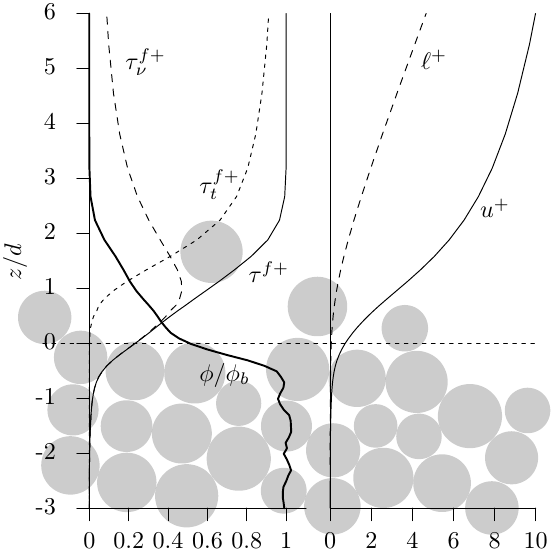
Fig. 1. Vertical profiles of the rescaled volume fraction φ/φ b , flow velocity u + = u/u ∗ , mixing length ‘ + = ‘/d , fluid borne + 2 shear stress τ f + = τ f /ρ f u 2 ∗ , viscous shear stress τ f ∗ ν = ν∂ z u/u + = (‘∂ z u) 2 /u 2 ∗ (by definition τ f + = and turbulent shear stress τ f t + f + = 0 is set at the altitude such τ f ν + τ t ). The reference height z that φ = φ b/ 2